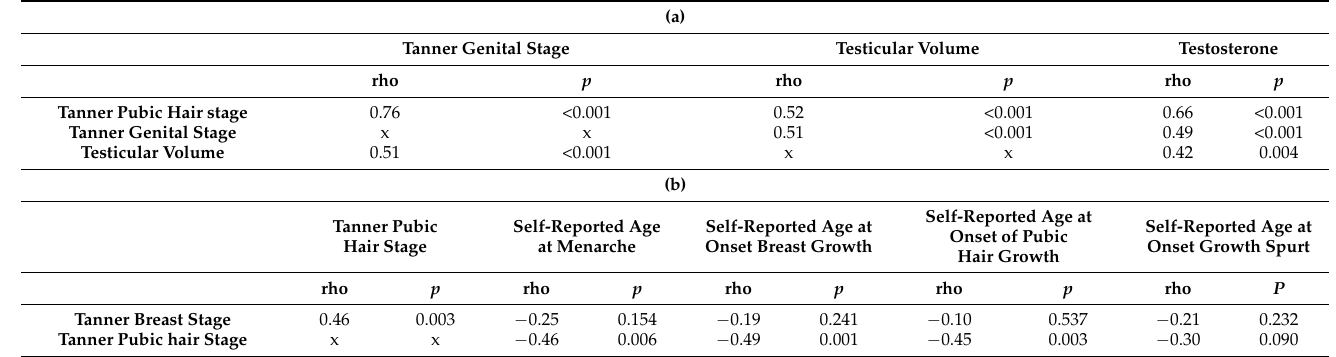
Table 4. ( a ) Spearman’s correlation coefficients between pubertal characteristics in boys. ( b ) Spear- man’s correlation coefficients between pubertal characteristics in girls.